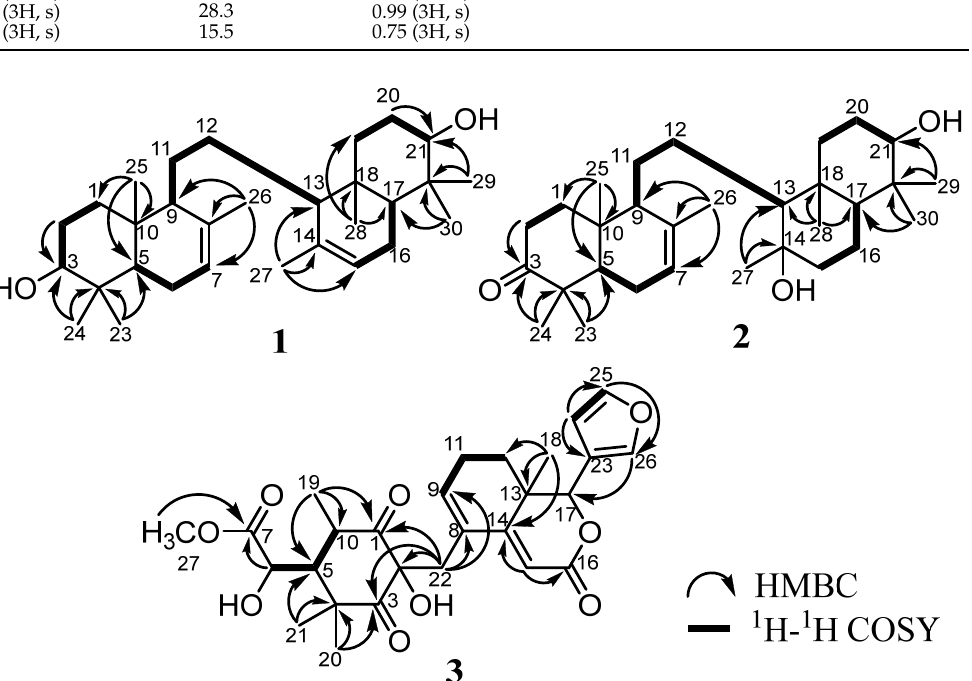
Figure 2. Selected HMBC and 1 H– 1 H COSY correlations for 1–3 .